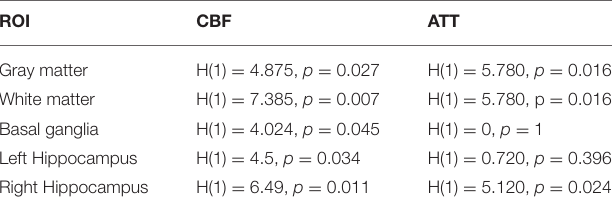
TABLE 2 | Group comparison between patients with cerebral small vessel disease and controls of the mean cerebral blood flow (CBF) and mean arterial transit time (ATT) in several regions-of-interest (ROIs).